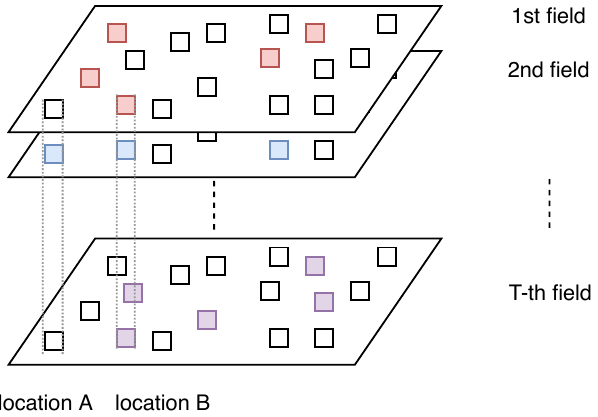
Figure 1. Illustration of the challenge of multi-type sensor